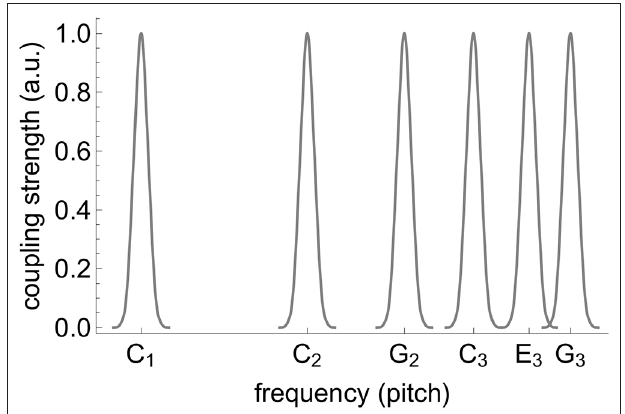
FIGURE 3 | Connectivity of the oscillator with eigenfrequency C 1 ( k Equation 24). The first “blob” represents connections which stem from input units with eigenfrequencies ranging from B ♭ 0 to D 1 and target the oscillator’s “slots” corresponding to ρ 1,1 , ρ 1,2 , ... , ρ 1,9 in Equation (24); likewise, the second blob connects B ♭ 1 , ... , D 2 to ρ 1,10 , ρ 1,11 , ... , ρ 1,18 etc. The connectivity of any other oscillator is obtained by shifting this kernel so that the center of the first blob is aligned with the oscillator’s